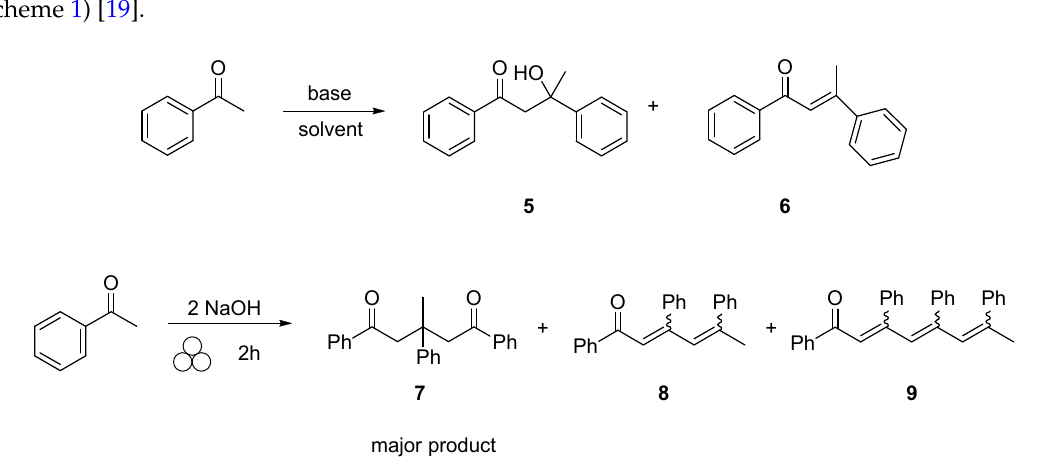
Scheme 1. Comparison of acetophenone self-aldol in solution versus mechanochemistry. 1,5-Diketones have been used as synthetic intermediates for heterocyclic and polyfunctional